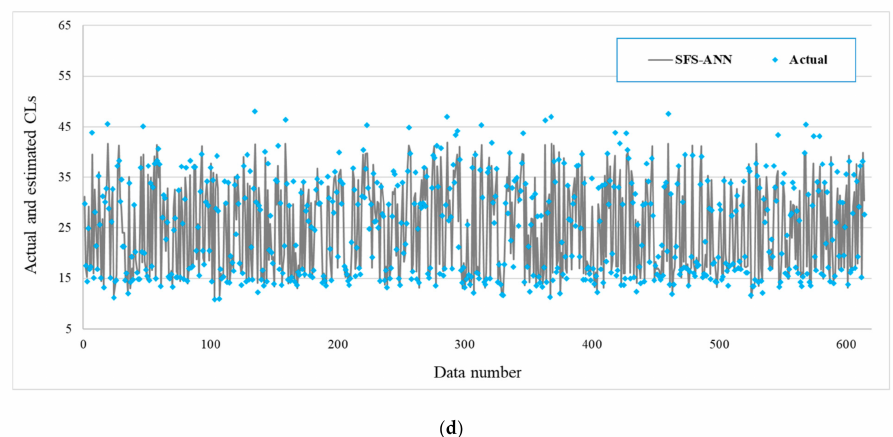
Figure 5. The measured CLs versus those predicted by ( a ) MLPNN, ( b ) GOA–ANN (GOA-optimized artificial neural network), ( c ) FA–ANN (FA-optimized artificial neural network), and ( d ) SFS–ANN (SFS-optimized artificial neural network) models.